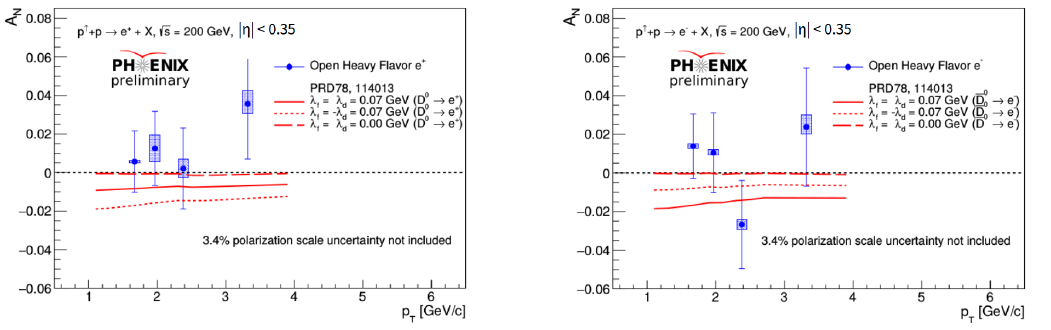
( p ) (blue), theoretical predictions of N T ( p ) from [ 12 ] + PYTHIA simula- T N